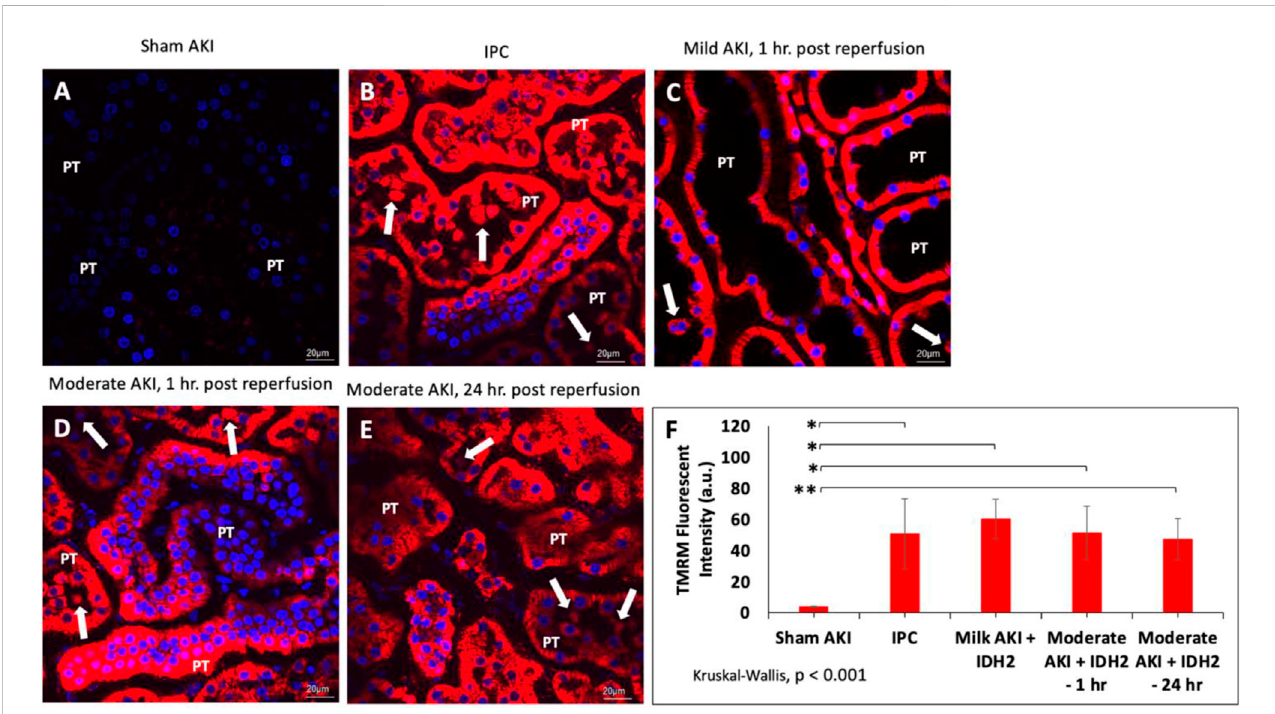
FIGURE 5 Mitochondrial membrane potential activity was examined in nephron segments of various live rats via TMRM-labeled signaling in (A) sham animals; (B) IPC animals; (C) animals with mild AKI that received hydrodynamic injections of IDH2 1 h after inducing IRI for 10 – 15 min; and (D) animals with moderate AKI that received hydrodynamic injections of IDH2 1 h after inducing IRI for 30 – 35 min; and animals with moderate AKI that received hydrodynamic injections of IDH2 24 h after inducing IRI for 30 – 35 min. (E) The mean TMRM -based fl uorescent intensity from each experimental condition ( n = 10 tubules per rat). Thearrows pinpoint fl uorescentcasts/cellulardebriswithinthetubularlumen.PT,proximaltubule. (F) MeanTMRM fl uorescentintensitiesthatwererecorded from the various experimental groups. Scale bar, 20 μ m, * represents p < 0.001, and ** represents p =